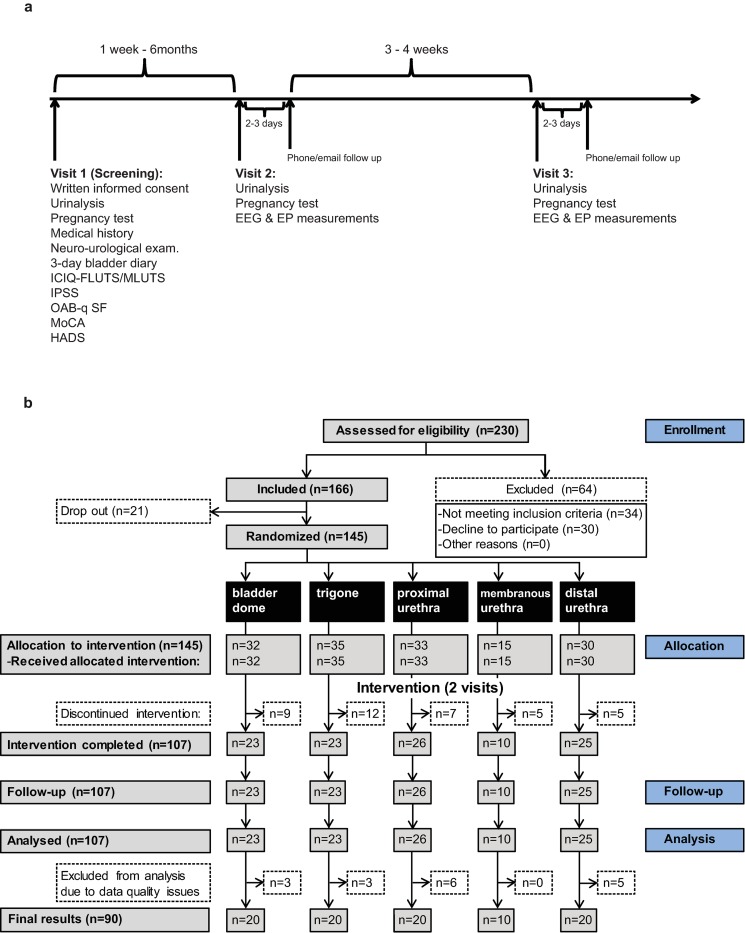
Study design and time schedule (a) and Consort diagram for flow of participants through the study (b). Reasons for discontinued intervention were: no participation in visit 2 (number of subjects: n = 18), catheter could not be placed (n = 14), uncomfortable feeling caused by catheter/stimulation (n = 5), poor health condition (n = 1). HADS: Hospital Anxiety and Depression Scale; ICIQ-FLUTS: International Consultation on Incontinence Modular Questionnaire Female lower urinary tract symptoms; ICIQ-MLUTS: International Consultation on Incontinence Modular Questionnaire Male lower urinary tract symptoms; IPSS: International Prostate Symptom Score; MoCA: Montreal Cognitive Assessment; OAB-q SF: The Overactive Bladder Questionnaire short-form.